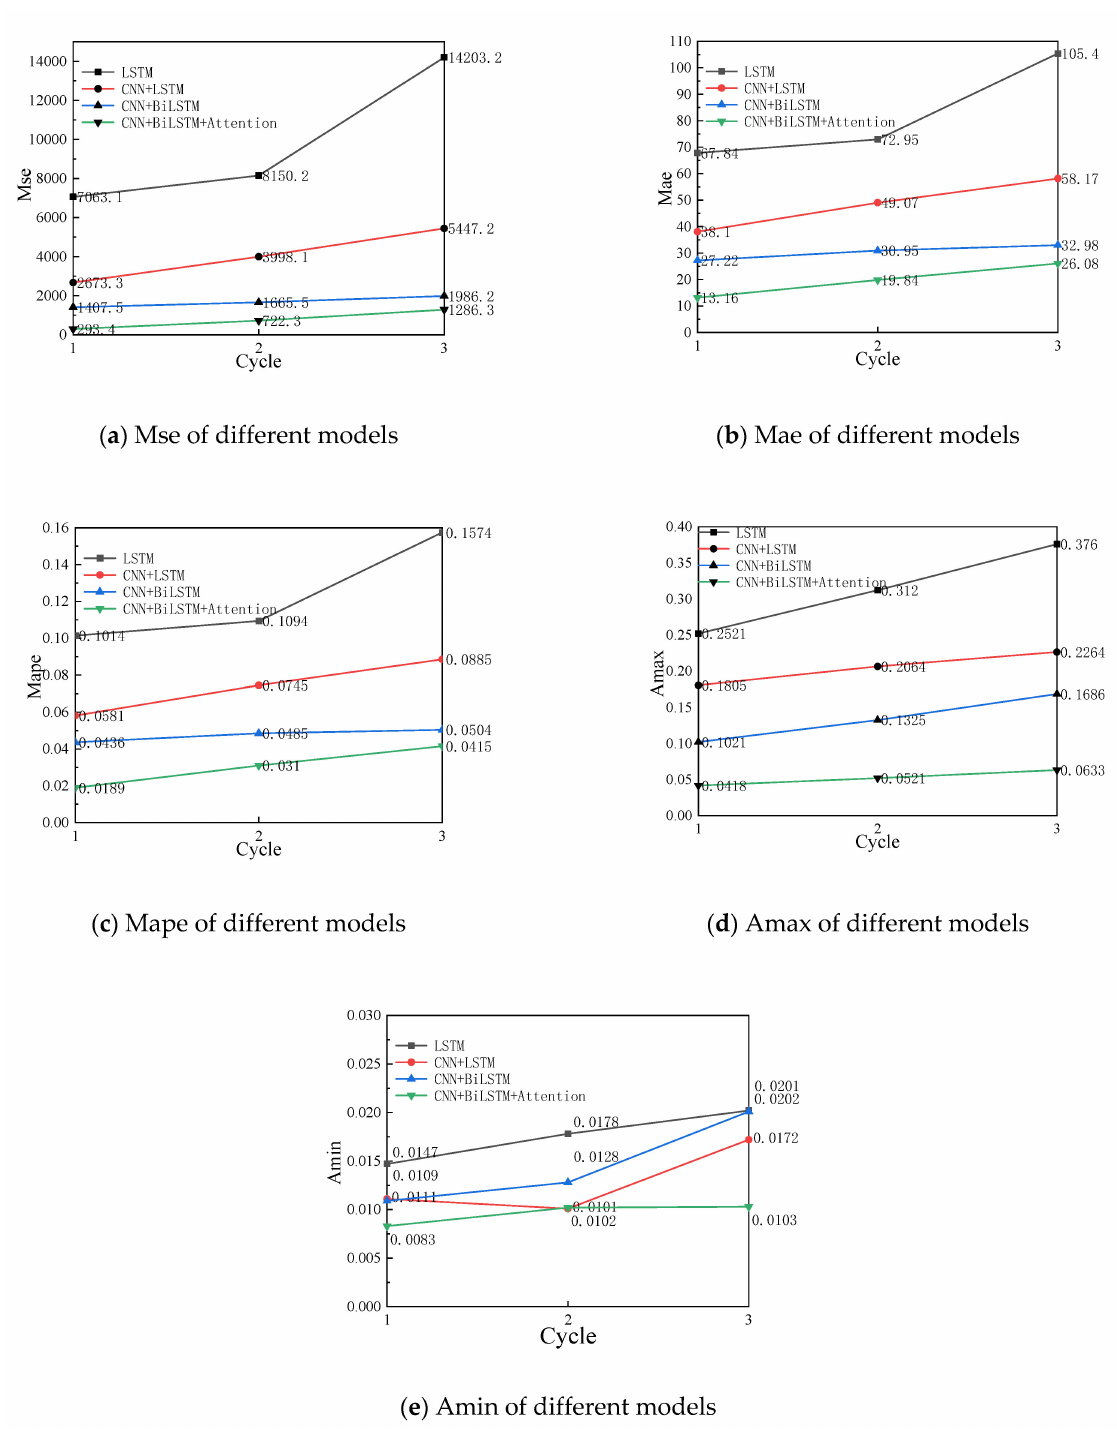
Figure 9. Comparison of different models’ prediction